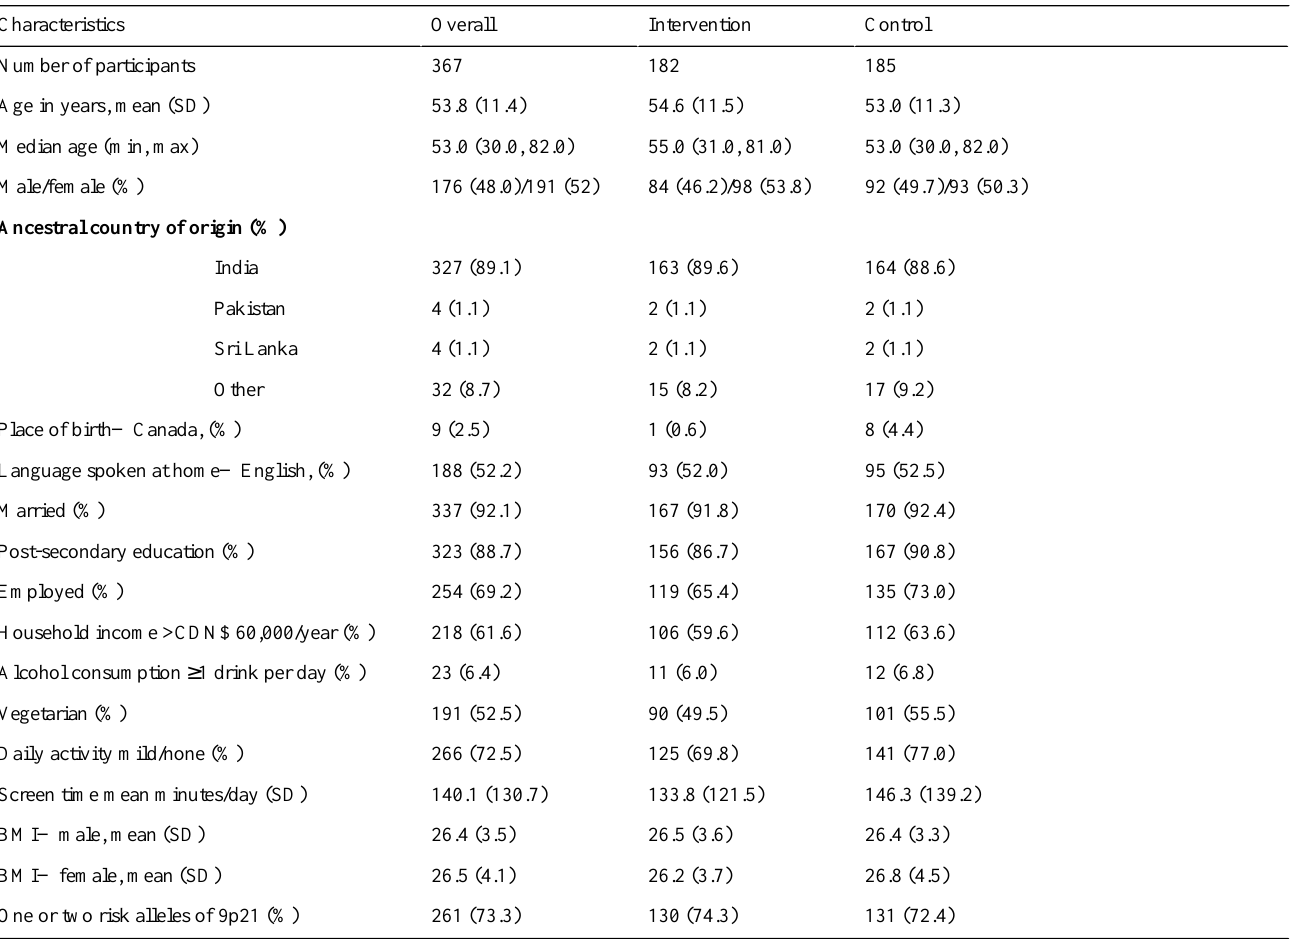
Table 1. Demographic